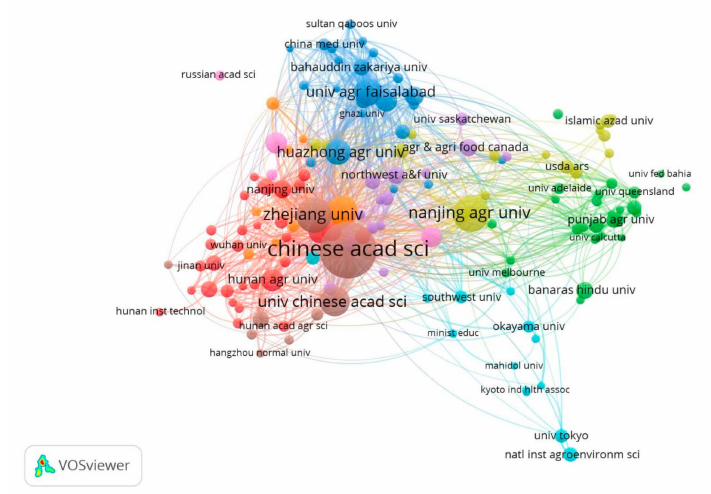
Figure 5. Analysis of research cooperation relationships between institutions.